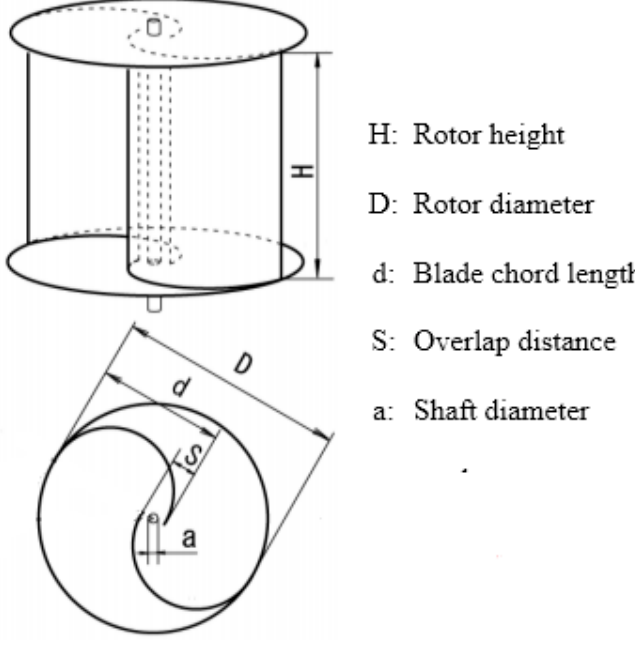
Figure 1. Geometrical parameters of Savonius rotor [12].